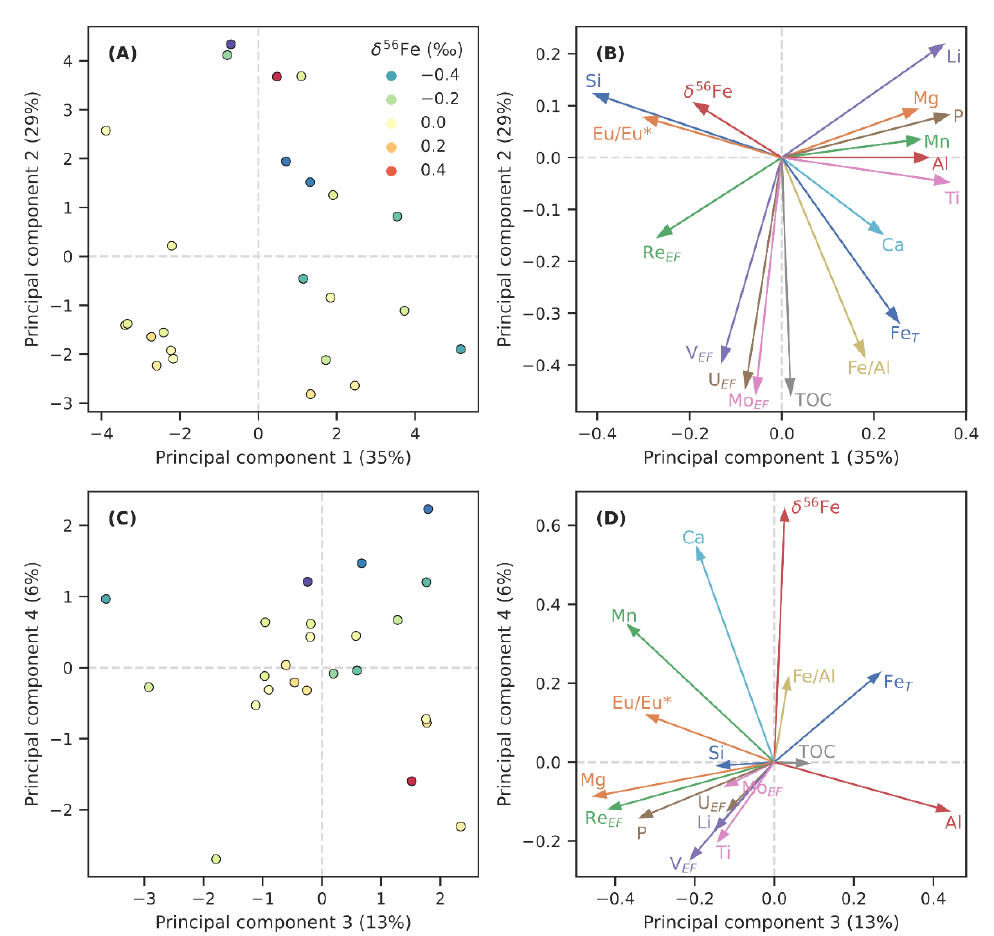
Figure 3. The results of principal component analysis on selected variables of the OnZaP dataset. Panels ( A , C ) show individual sample scores for components 1 and 2, and 3 and 4, respectively (colour scale reflects iron isotope composition, δ 56 Fe). Panels ( B , D ) show the loadings that the respective principal components place on the analysed chemical variables.